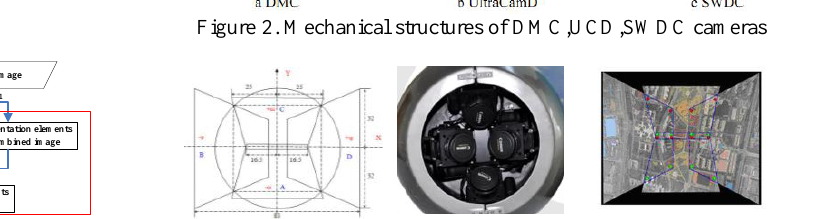
Figure 3. The structure of the designed four-combined wide- angle camera(Unit: mm, view angle:100 °× 130 ° )